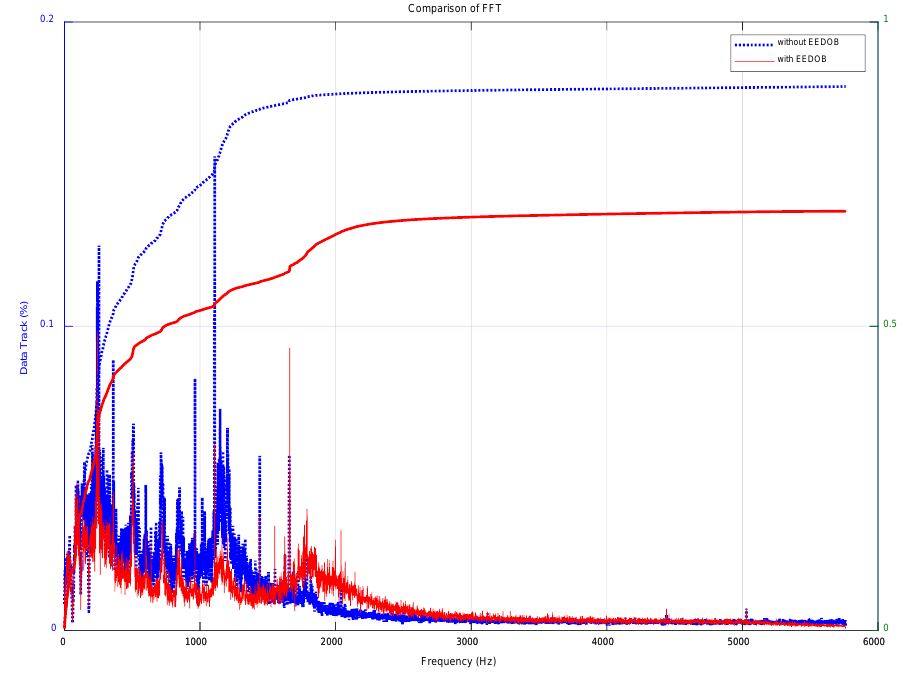
Figure 12. Power spectral density and cumulated sum.